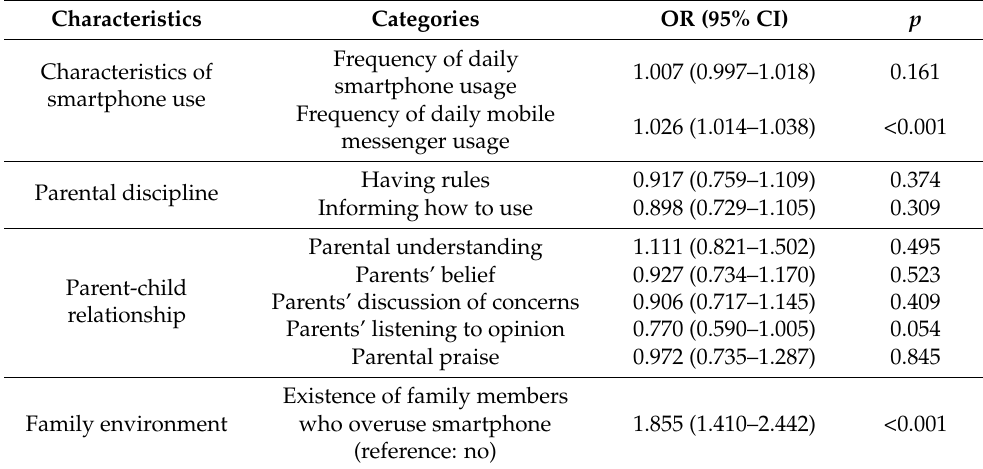
Table 4. Factors of problematic smartphone use among female adolescents ( n =